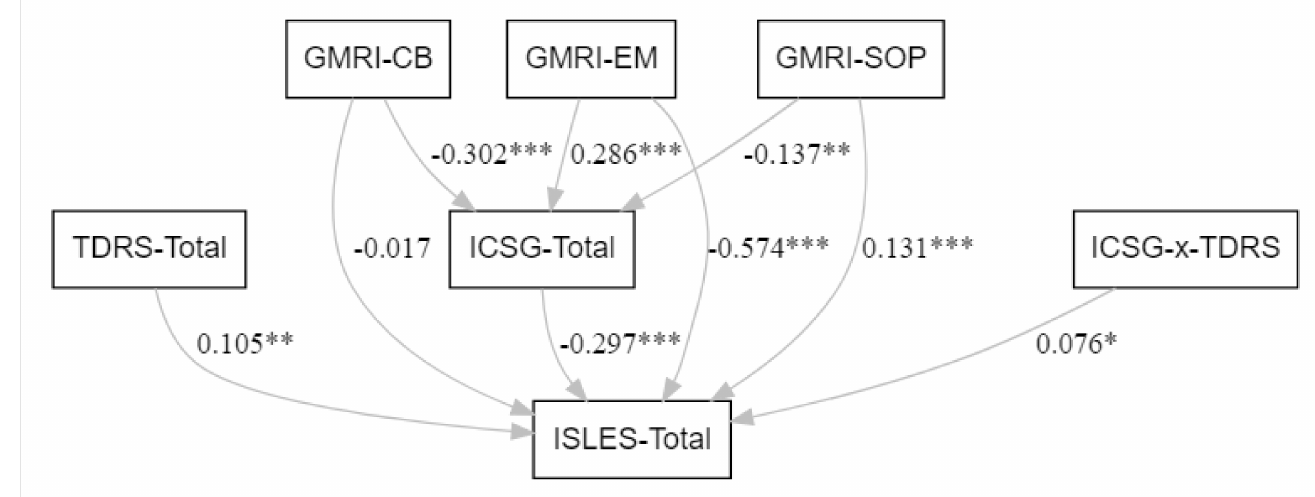
Figure 1. Path model (standardised coefficients; * p < 0.05, ** p < 0.01, *** p <